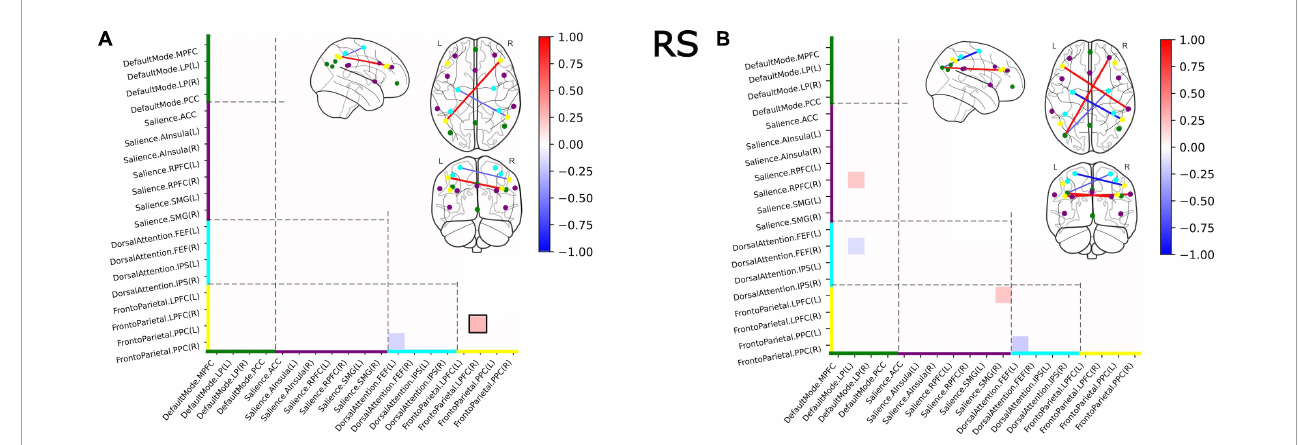
FIGURE4 Group differences in functional covariance of RS within and between four major brain networks for the full sample (A) and for the subsample of subjects with a current psychiatric diagnosis (B) . Squares indicate significant differences in partial correlations between victims and controls. Colors on the axes and of the nodes correlated with the networks: DMN–green, SN–purple, DAN–cyan, FPN–yellow. Nodes with within-network differences were highlighted with black squares.